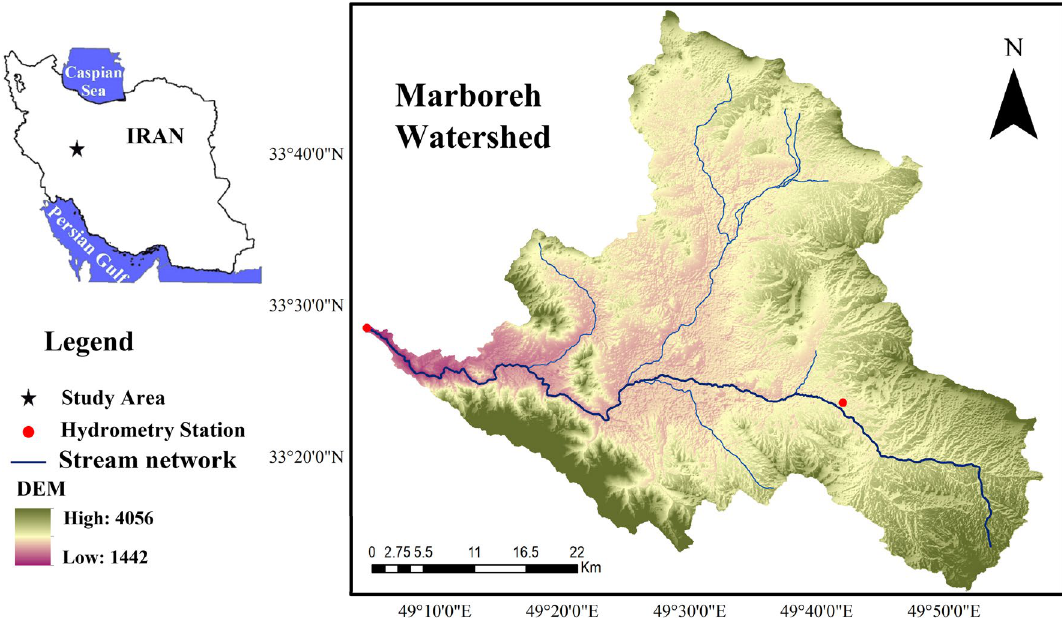
Figure 1. Location of the study area in Lorestan Province,